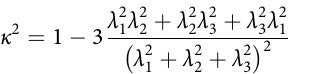
It reaches 1 for the limiting case of a rod-like cluster (linear chain in case of polymers) and drops to zero for symmetric conformations (a sphere). Anisotropy converges to 0.25 for objects with planar symmetry 25,26 . The protein clusters in the 50% plasma concentration are more symmetrical compared to the 10% plasma concentration, as shown in Fig. 10c. The symmetry